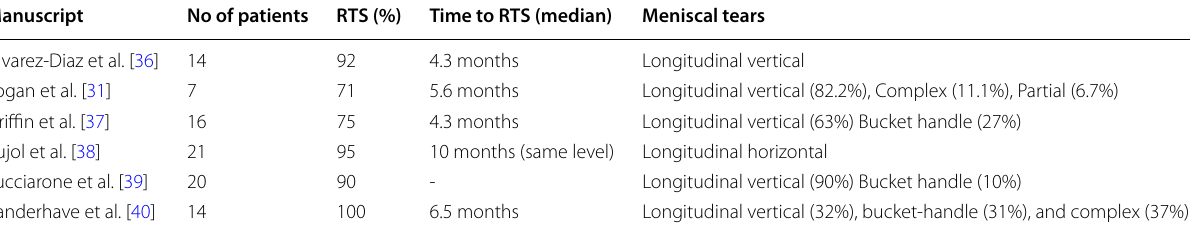
Table 4 Studies analyzing RTS after isolated meniscal